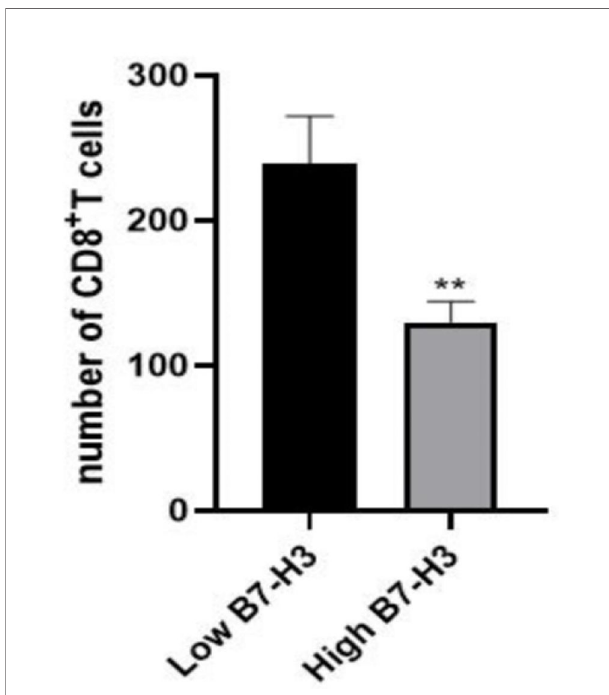
FIGURE 6 | The number of tumor-in fi ltrating CD8 + T-cell was inversely correlated with B7-H3 expression in 24 patients with LSCC (** p < 0.01). This correlation was tested by Wilcoxon rank sum test.